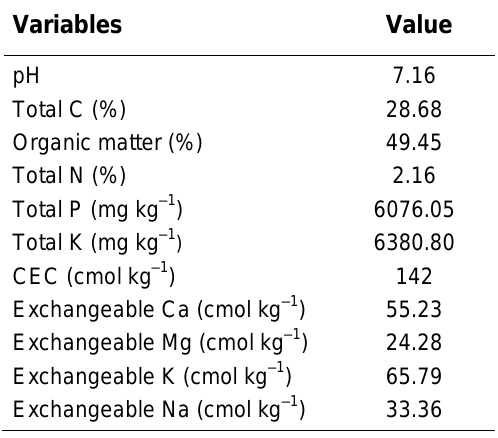
Selected Chemical Characteristics of